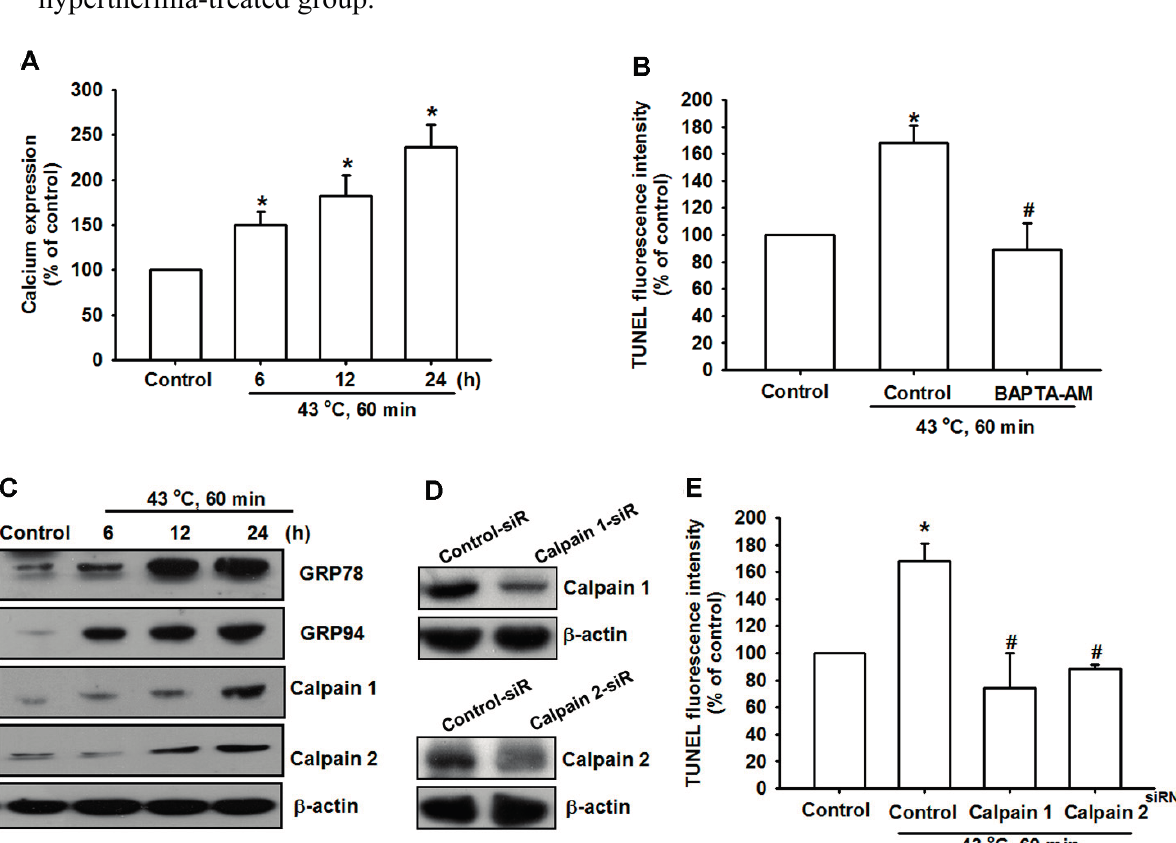
Figure 4. Hyperthermia-induced Ca 2+ release and ER stress in OS cells. ( A ) U-2 OS cells were incubated with hyperthermia (43 °C, 60 min). After different time intervals, the Ca 2+ expression was examined using flow cytometry ( n = 4); ( B ) U-2 OS cells were pretreated for 1 h with BAPTA-AM (10 μ M) followed by stimulation with hyperthermia (43 °C, 60 min). After 24 h, the percentage of apoptotic cells was then analyzed by conducting flow cytometric analysis on a TUNEL assay; ( C ) U-2 OS cells were incubated with hyperthermia (43 °C, 60 min). After different time intervals, GRP-78, GRP-94, calpain I, and calpain II expression were examined using Western blot analysis; ( D , E ) U-2 OS cells were transfected with calpain I, calpain II, or control siRNA for 24 h before incubation with hyperthermia (43 °C, 60 min). After 24 h, the percentage of apoptotic cells was then analyzed by conducting flow cytometric analysis on a TUNEL assay. The results are expressed as the mean ± SEM. * , p < 0.05 compared with the control. #, p < 0.05 compared with the hyperthermia-treated